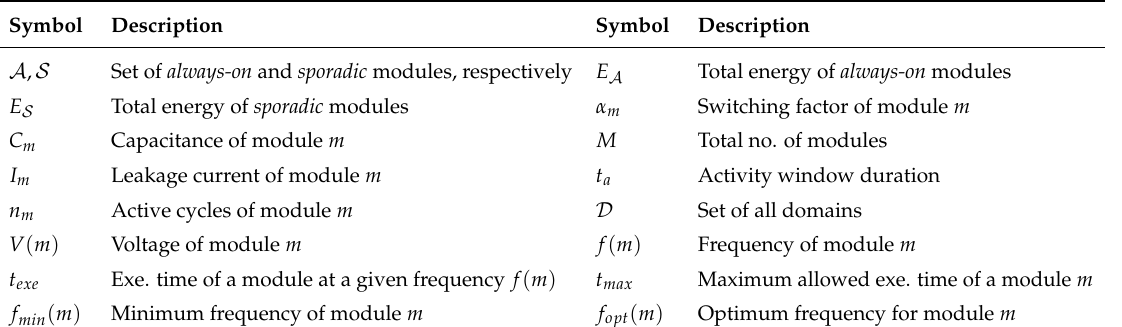
Table 1. List of major parameters ( m ∈ {A , S}